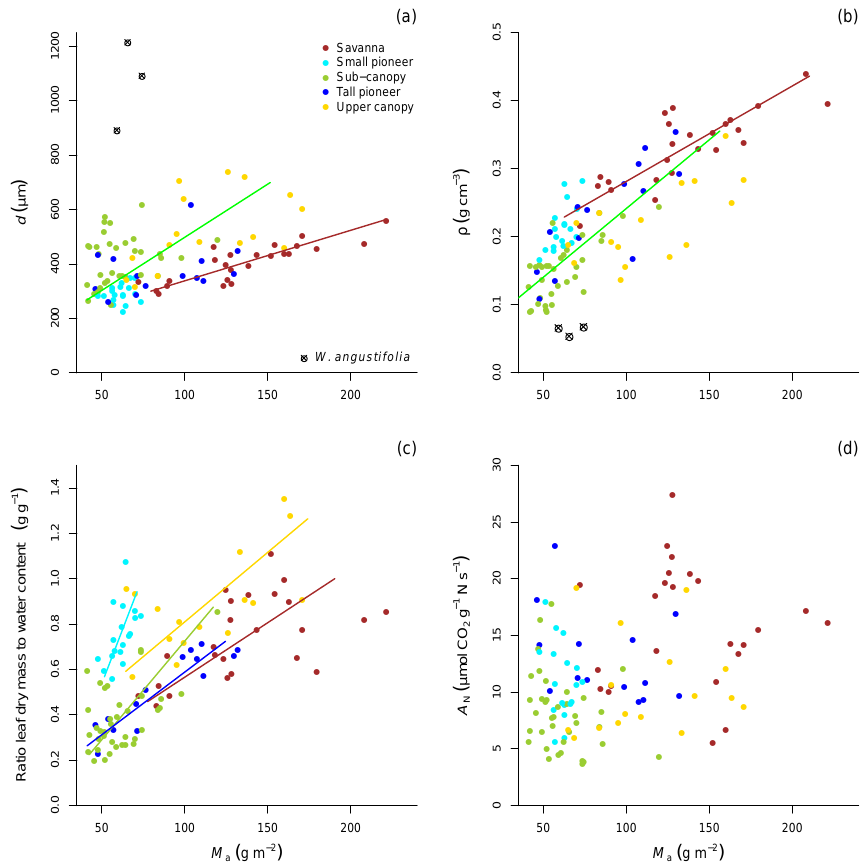
Figure 5. Scatterplots of the relationship with leaf mass per unit area for (a) leaf thickness (measured fresh), (b) leaf density (derived as M a /d ), (c) the ratio of leaf dry mass to water content and (d) photosynthetic N use efficiency. Each point represents one tree and separate φ values are distinguished by colour. SMA-fitted lines are shown in the top panel for the two vegetation types: F in green and S in brown. Outlying values for Wilkiea angustifolia (crossed circles) were excluded from the SMA analyses of plots (a) and (b) . In plot (c) a separate fitted line is shown for each φ . Pearson’s correlations testing the assumption of linearity are given in Table S4 together with the likelihood ratio and Wald statistics testing the H 0 of common slope, elevation and axis shift for the two V classes. SMA intercept, slope and r 2 values are given in Table 3. There was no relationship A N ↔ M a for individual levels of V or φ